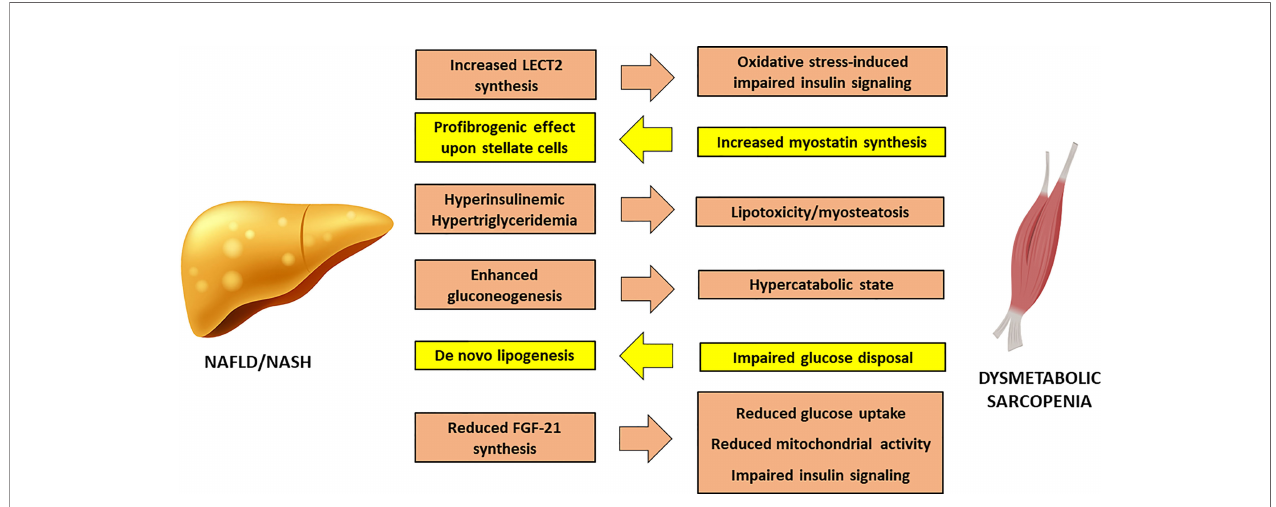
FIGURE 2 | Cross-talk between Non-Alcoholic Fatty Liver Disease and sarcopenia. FGF-21, Fibroblast Growth Factor – 21; LECT2, Leucocyte cell-derived chemotaxin 2; NAFLD, Non-Alcoholic Fatty Liver Disease; NASH, Nonalcoholic